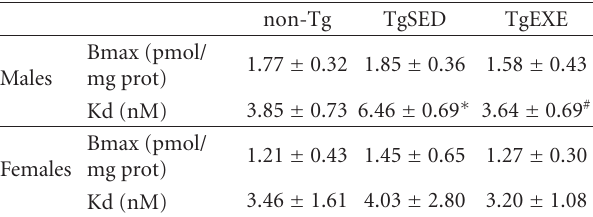
Table 2: Treadmill exercise recovers the [ 3 H] flunitrazepam binding parameters of cerebral cortical tissue of 3xTgAD